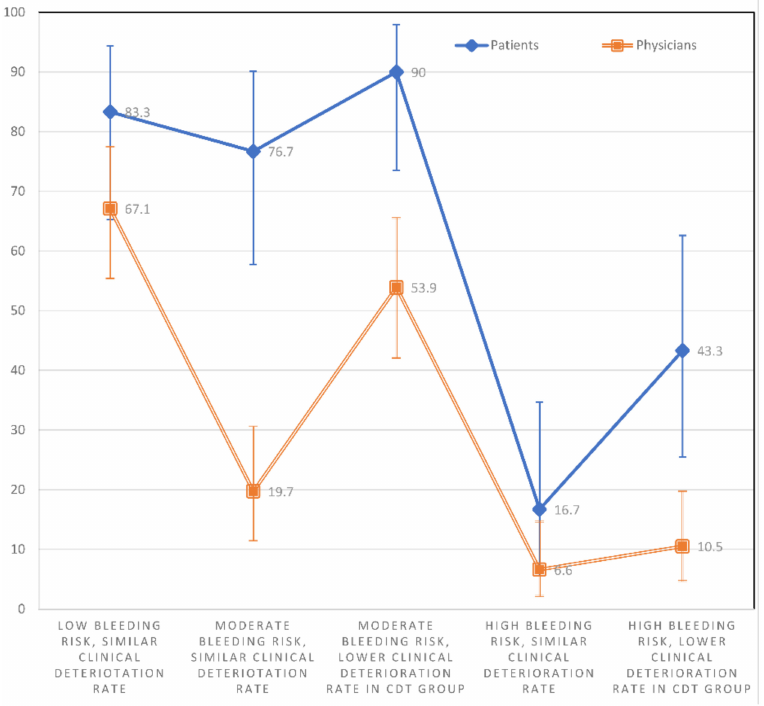
Figure 4. The percentage with 95% confidence intervals of physicians and patients showing a preference for CDT (score > 3) within each individual